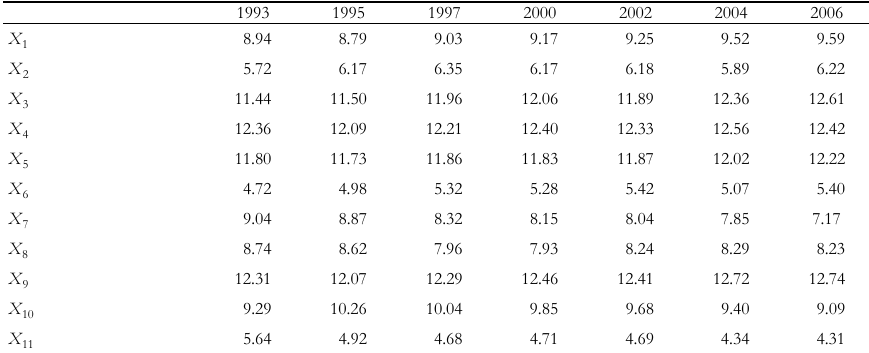
Contribution to the multidimensional poverty ratio by attribute and by year (per cent values) 1993